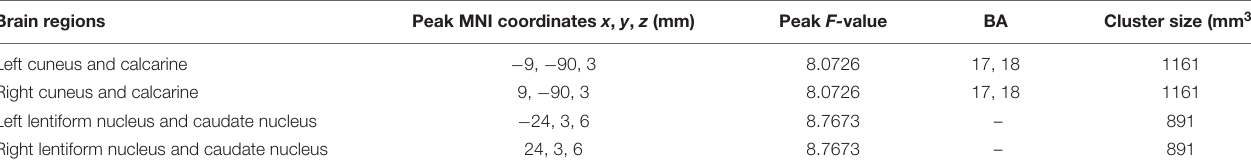
TABLE 2 | Brain regions with significant differences in VMHC between